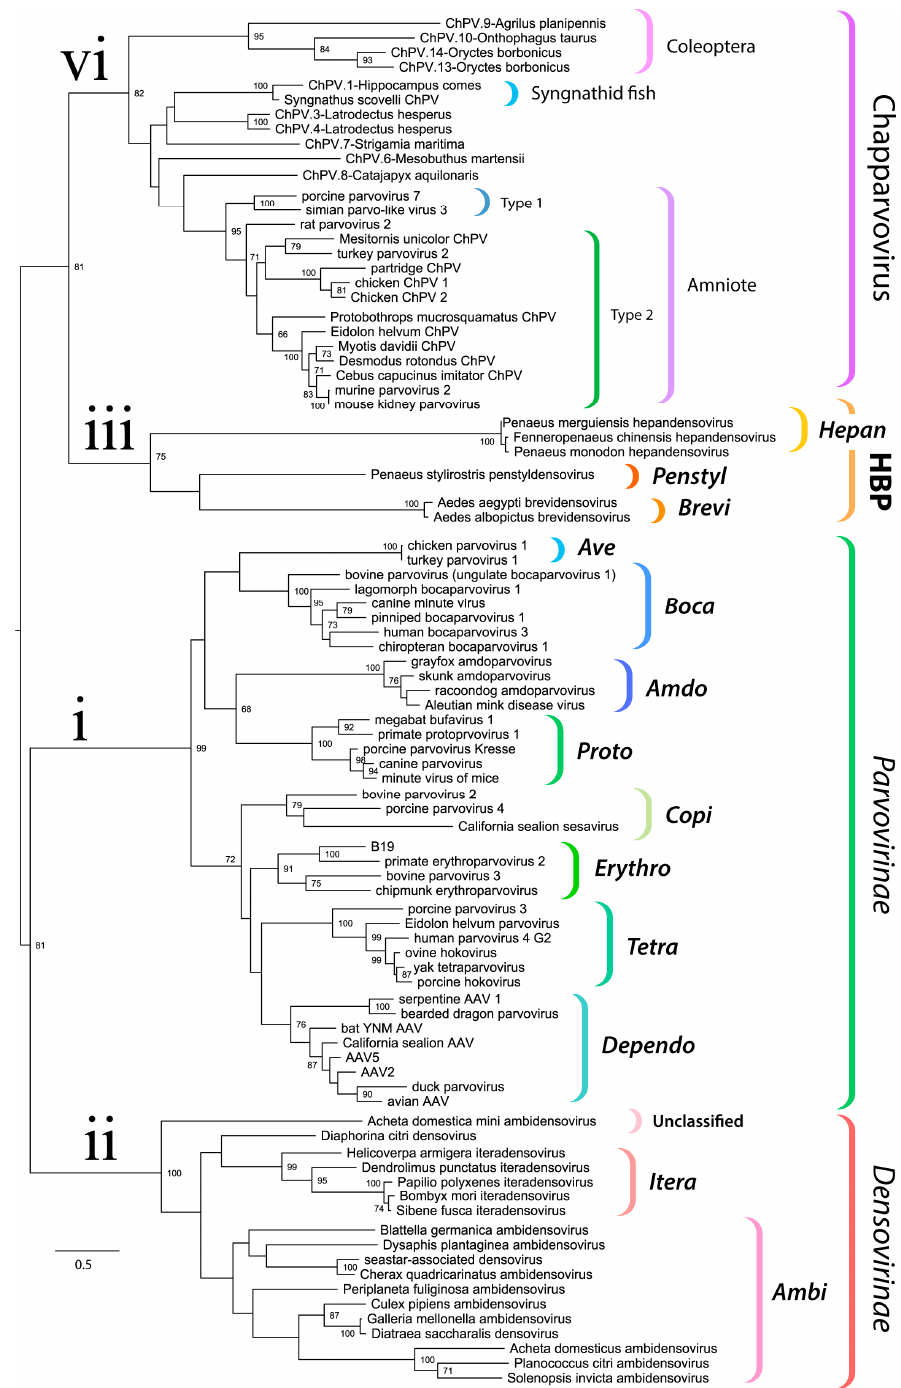
Figure 3. Evolutionary relationships within the family Parvoviridae reconstructed via phylogenetic analysis of the tripartite helicase domain. The four major splitswithin the Parvoviridae are indicated inthe tree as follows: (i) Parvovirinae (ii) Densovirinae (excluding genera Hepan -, Brevi -, and Penstyldensovirus , abbreviated as HBP); (iii) HBP; (iv) Chapparvovirus (ChPV-related viruses and EPVs). Brackets to the right indicate taxonomic groups. The names of established genera are shown in bold italics in the abbreviated form (i.e., with the su ffi x “parvovirus” omitted). The scale bar shows evolutionary distance in substitutions per site. Numbers adjacent to tree nodes show bootstrap support (based on 100 bootstrap replicates) where >